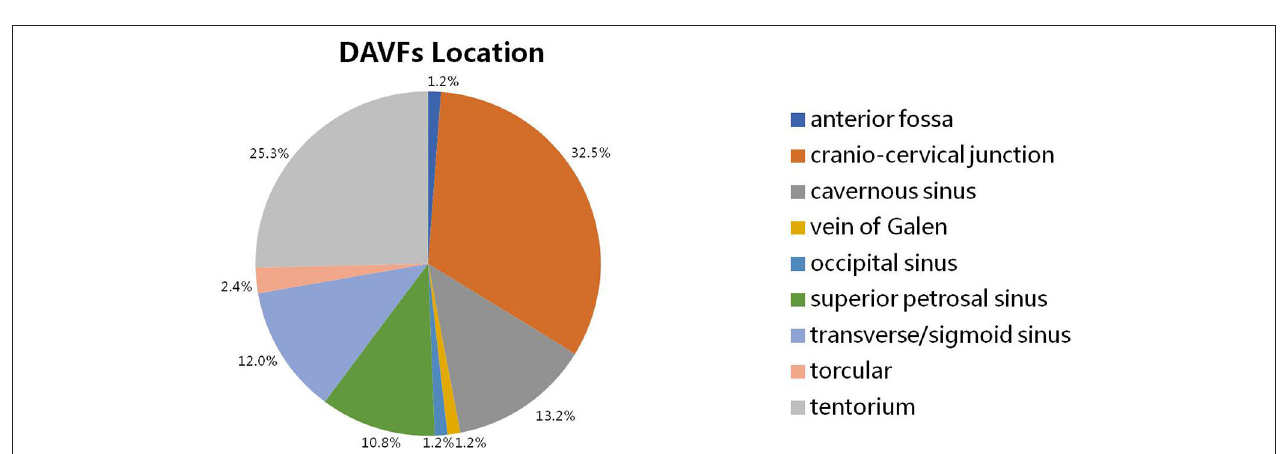
FIGURE 3 | The specific location of intracranial DAVFs complicated with brainstem engorgement. DAVF, dural arteriovenous fistula.